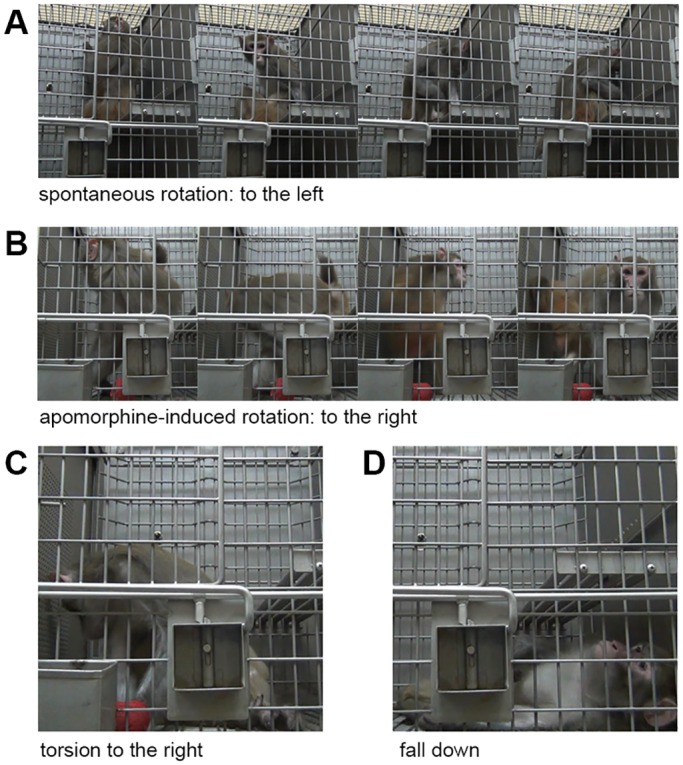
Representative images of the rotation and torsion of MPP+ treated monkeys.
(A) A spontaneous rotation (to the left side of body) occurred when the monkeys were sitting without any disturbance. (B) An APO-induced rotation (to the right side of body) occurred 15 minutes after APO (1 mg/ml; 2 ml, i.m.) injection. (C) During the APO-induced rotation, the monkeys had a tendency to stop rotating and maintain a torsion posture for several to tens of seconds. The body was extremely distorted, with head turning right and backwards. (D) Sometimes a severe torsion might even lead to the loss of balance and falling down.